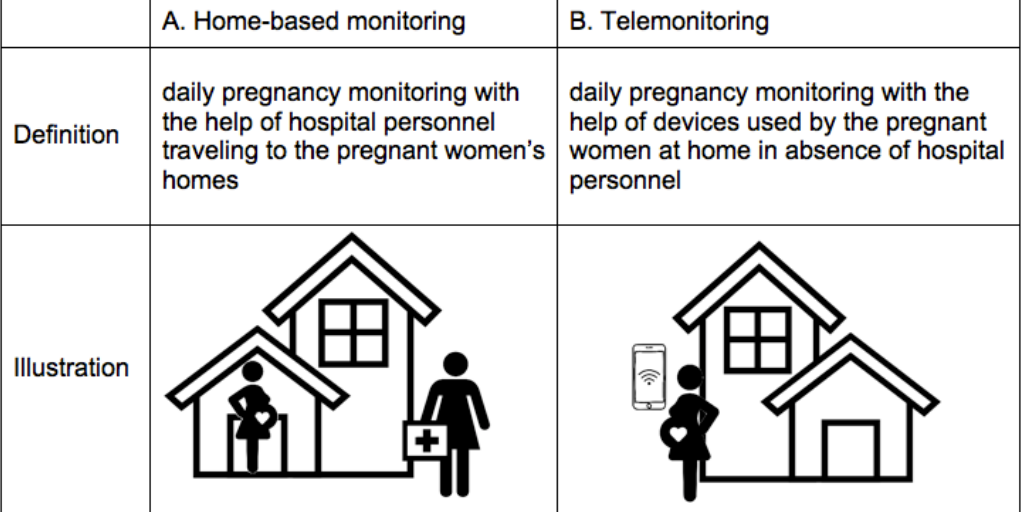
Figure 1. Definition and illustration of (A) home-based monitoring and (B) telemonitoring in